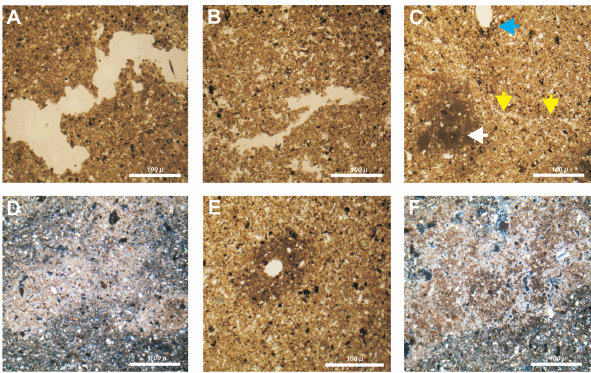
Fig. 7. Finca Gatica locality: photomicrographs of micromorpho- logical features (PPL: plane polarized light. XPL: crossed polar- ized light). (A–B) Chambers with mamillate surface roughness. Microphotograph (B) also shows zones with spongy-like structure (samples: FG 1 and FG 2, PPL). (C) Calcitic impregnation (white arrow), slight hypocoating and calcitic diffusion around a void (light blue arrow) and a crack (yellow arrows) (sample: FG 2, PPL). (D) Calcitic diffusion in the soil mass (sample: FG 1, XPL). (E) Calcitic hypocoating and diffusion around a void (sample FG 1, PPL). (F) Calcitic diffusion in the soil mass (sample: FG 2,